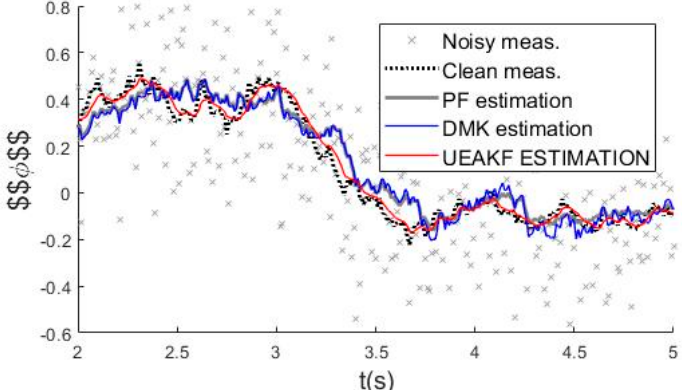
Figure 8. ∅ (cid:3041) mean and standard deviation of the 𝑛𝑅𝑀𝑆𝐸 of the clean measurement estimations. Figure 8. ∅ n mean and standard deviation of the n RMSE of the clean measurement estimations.